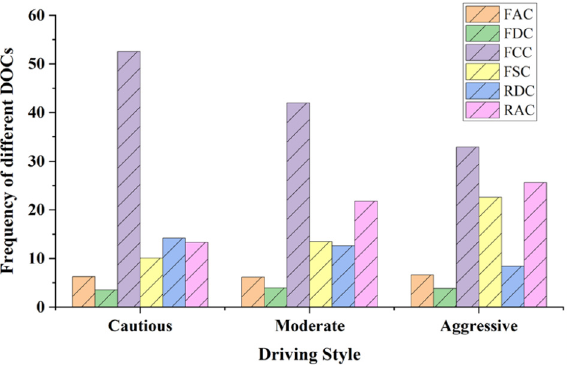
Figure 13 Frequency of different DOCs between different driving style